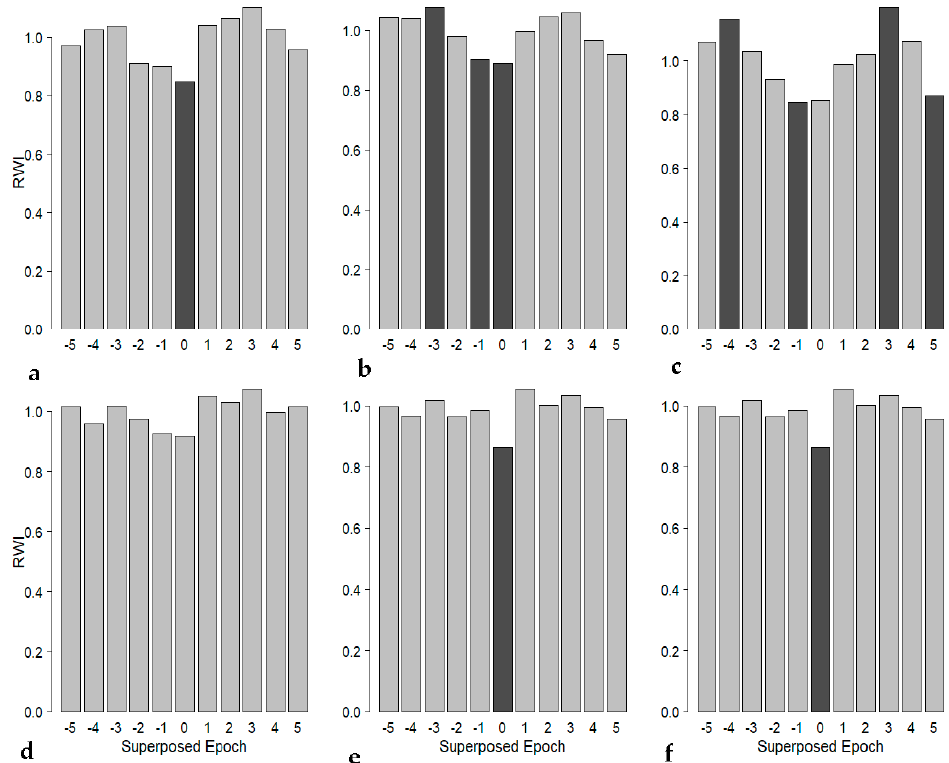
Figure 10. Results of superposed epoch analysis (SEA) showing the significant influence of droughts in 1992, 1994, 1999 and 2006 on Scots pine ( Pinus sylvestris ) provenances, representing ( a ) eastern, ( b ) central, ( c ) northern, ( d ) southern, ( e ) western locations and ( f ) all provenances. In the figure, 0 indicates the event year, − 1, − 2, and − 5 and +1, +2 and +5 show one, two and five years before and following the drought events, respectively. The dark-colored bars indicate a significant growth reduction ( p < 0.05).